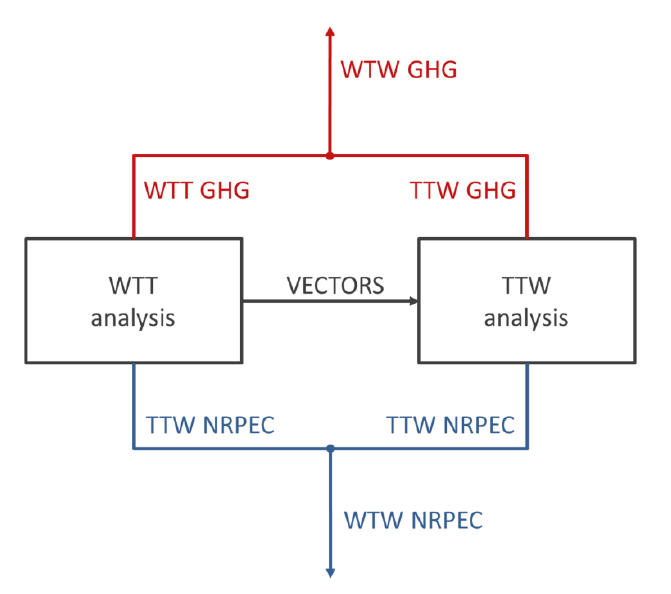
Figure 1. Well-to-wheel (WTW) analysis scheme.